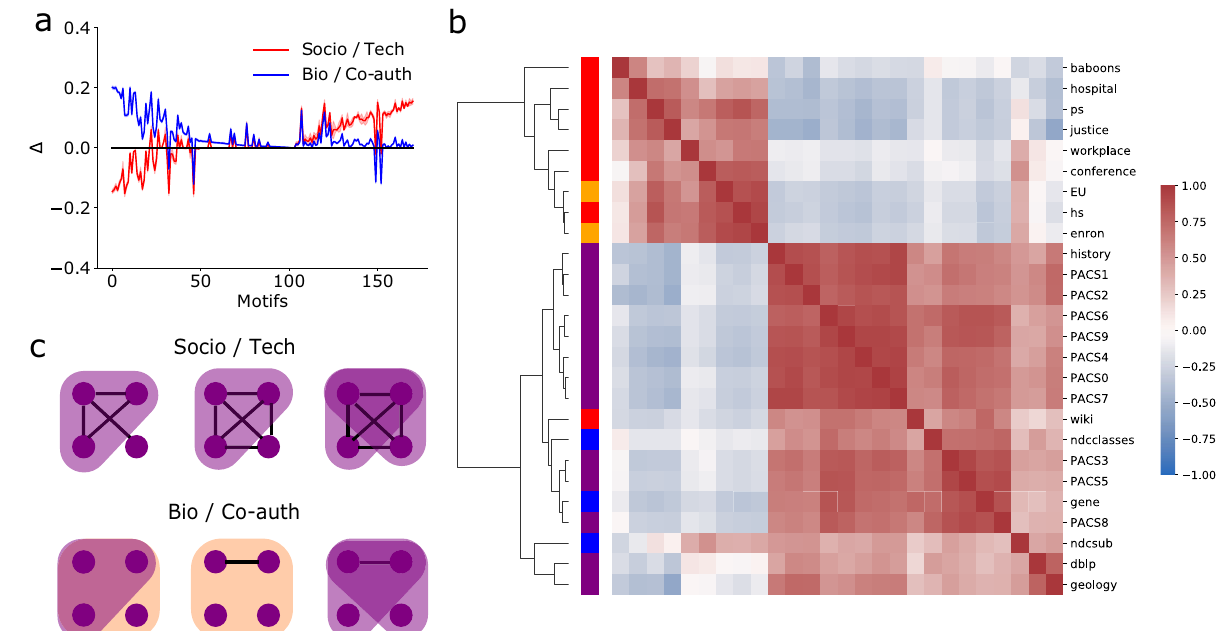
Fig. 3 Analyzing the local structure of hypergraphs via higher-order motifs of order 4. a Signi fi cance Pro fi les (SP) of hypergraphs from higher-order motifs of order 4. Δ is the abundance of each motif relative to random networks. SPs are much more complex due to the increase in the number of considered patterns of higher-order interactions. We group and average the SPs of networks from the same higher-order family (i.e., Socio/Tech and bio/ Co-auth) and sort the motifs on the x -axis based on their ability to discriminate the two higher-order families. Distinct characteristic higher-order motifs of order 4 are associated with the two classes of networks. The shaded area represents the standard error of the mean. If the shaded area is not visible, it is of the same size as the line thickness. b Correlation matrix of the investigated datasets computed on SPs of order 4. The matrix provides richer information than its equivalent at order 3 on the local structure of networks: the two big clusters emerge again but are better separated, and display a richer intra- cluster hierarchical structure. Each row of the correlation matrix is labeled with different colors depending on the domain of the respective dataset: red for the social domain, orange for e-mails, purple for the co-authorship domain and blue for the biological domain. Moreover, we show the clustering tree computed by applying a hierarchical clustering algorithm on the signi fi cance pro fi les, considering correlation as a measure of similarity. With respect to the analysis with higher-order motifs of order 3, the clustering tree highlights a better separation between the two big clusters, as well as a richer intra-cluster hierarchical organization. In the correlation matrix, red squares represent a high correlation while blue squares represent a low correlation. c The six most representative higher-order motifs from the two clusters. Purple shaded triangles and orange shaded squares represent respectively higher-order interactions of size 3 and 4, whereas black lines represent pairwise